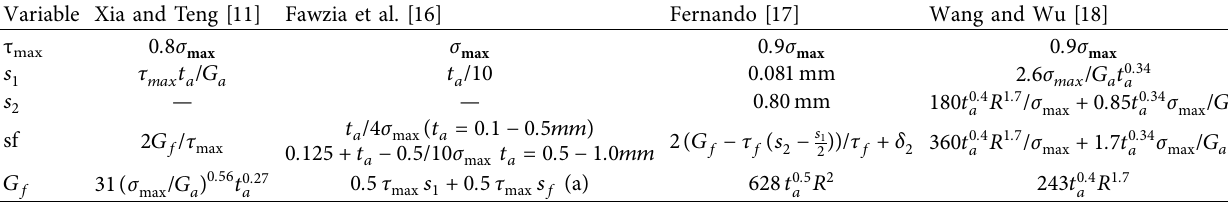
Table 1: Existing bond-slip models for FRP-steel joints.